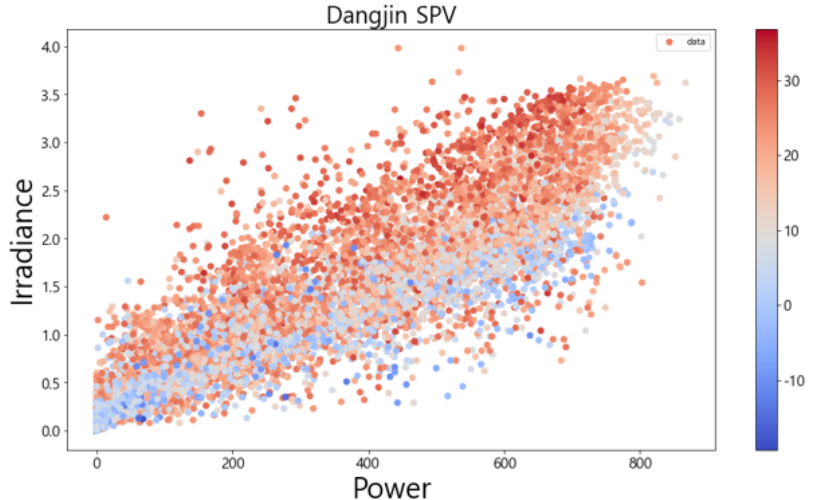
Figure 3. Irradiance—Power Graph by Table 1 and Dangjin SPV power generation amount data. Furthermore, color is presented with temperature data in Table 1.